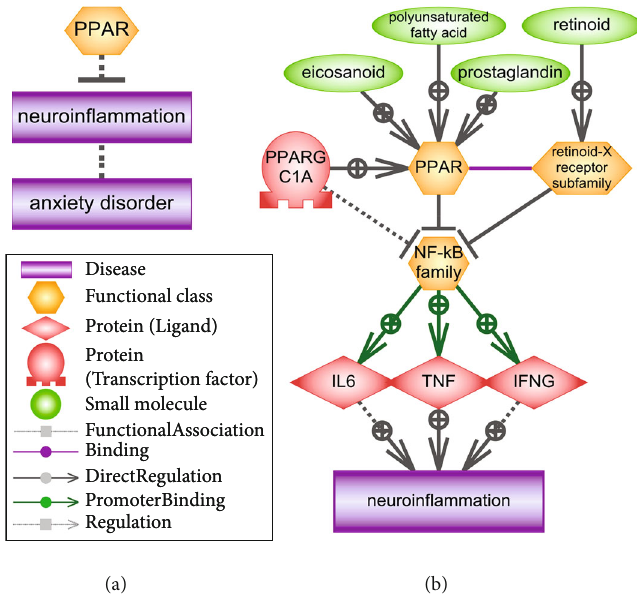
Figure 4: The association of PPARs with neuroin fl ammation. (a) The e ff ect of PPARs on neuroin fl ammation and the association of neuroin fl ammation with anxiety. (b) The signaling pathway of the blockade by activated PPARs of the transcription factor NF-kappa B, an activator of transcription of cytokines IL6, TNF, and IFNG. The legend in the fi